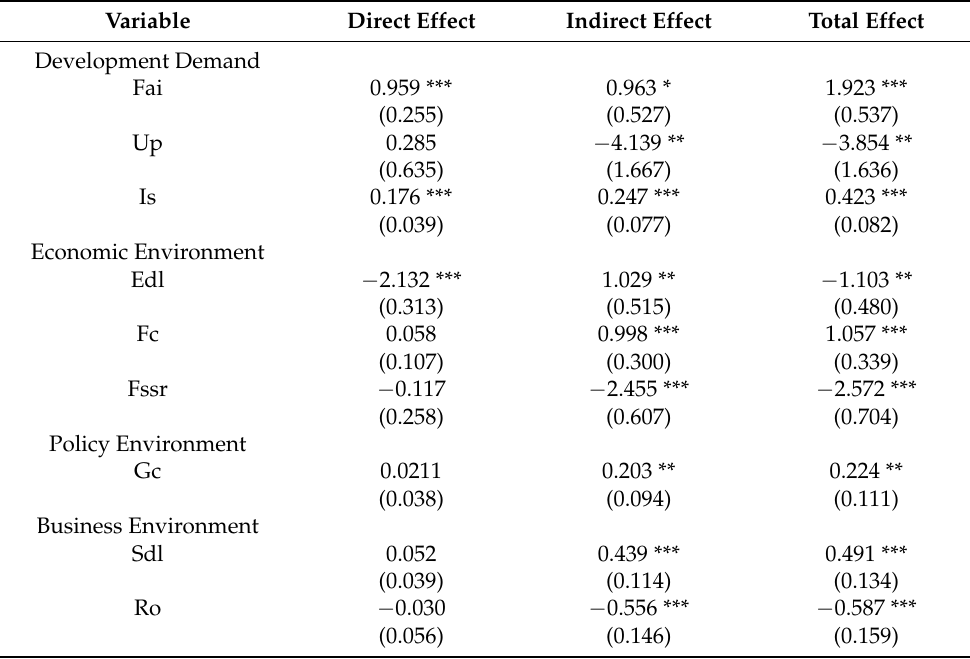
Table 5. Direct, indirect, and total effects of the SDM with spatial–temporal fixed effects (source: authors’